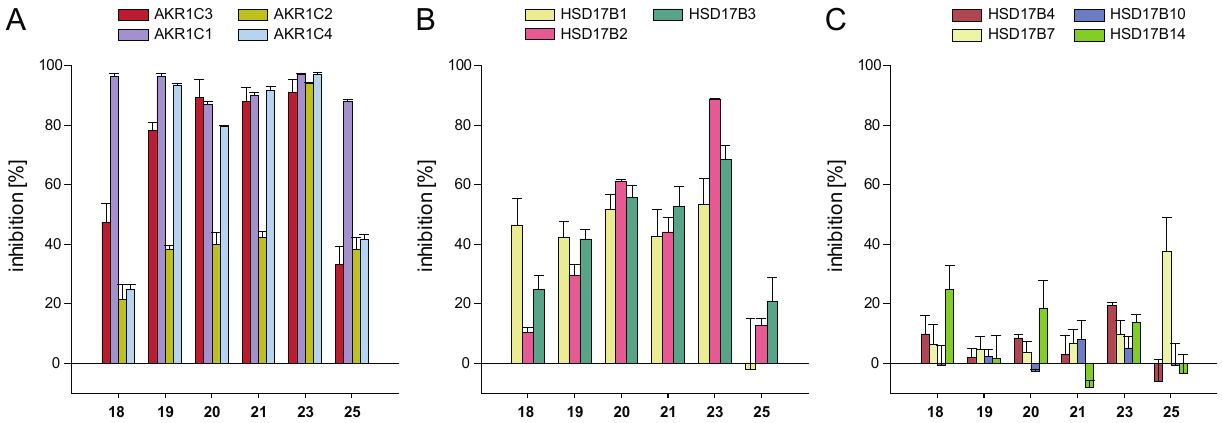
Figure 3. Inhibition of enzymes of the AKR1C and 17β-HSD families by selected chalcones: ( A ) inhibition of the enzymes AKR1C1, AKR1C2, and AKR1C4 in comparison with AKR1C3; ( B ) inhibition of SDR enzymes HSD17B1, HSD17B2, and HSD17B3 primarily involved in steroid hormone metabolism; ( C ) inhibition of SDR enzymes not primarily involved in steroid hormone metabolism. Experiments were performed in triplicates, and mean values ± SD are shown.